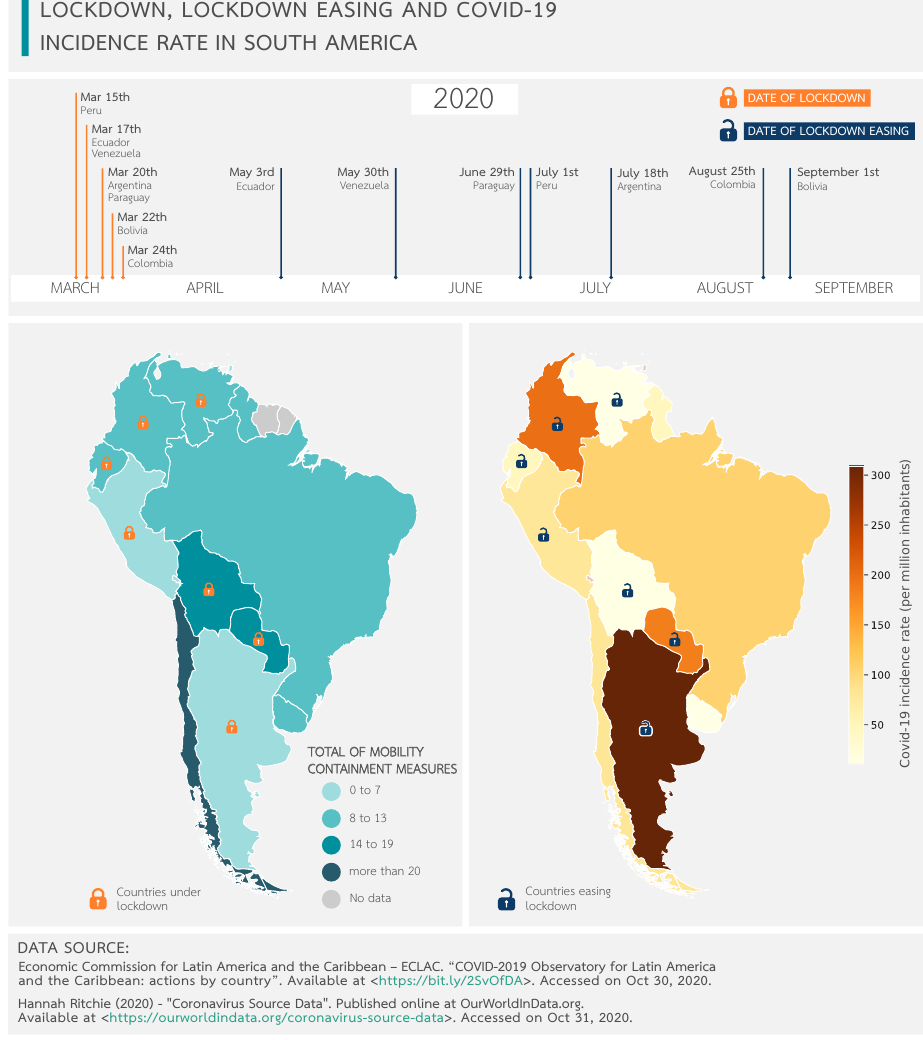
Figure 5. Lockdown, lockdown easing, and Covid-19 incidence rate in South